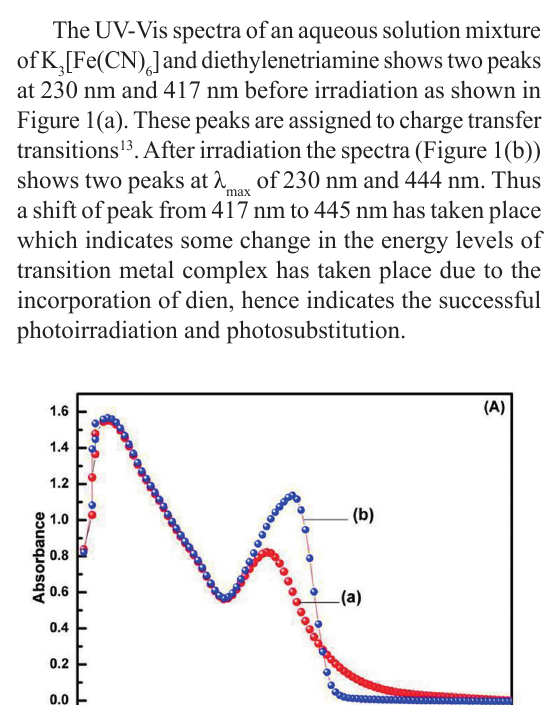
Figure 1: UV-Visible spectra of : aqueous solution of K and diethylenetriamine (dien) (a) before irradiation and (b) after